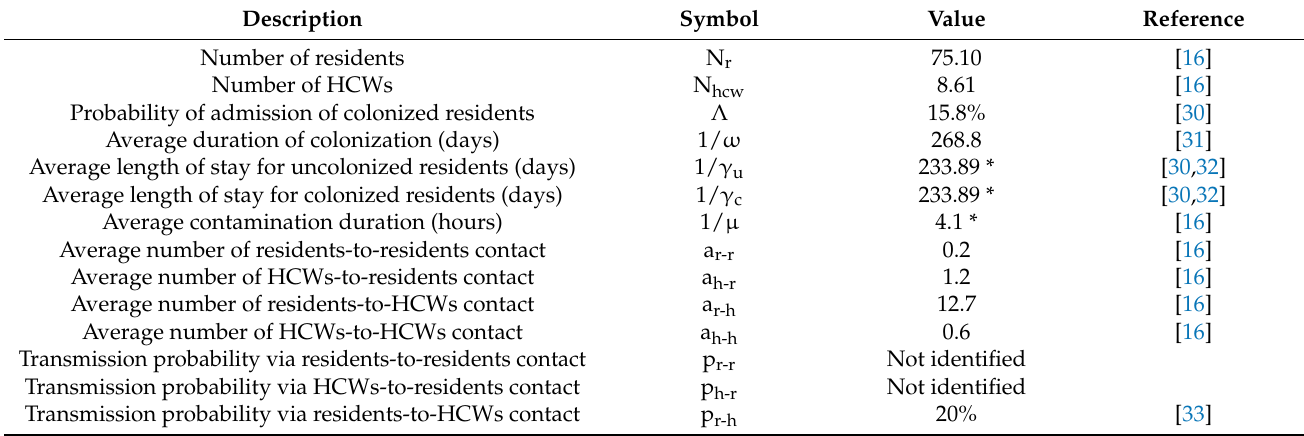
Table 5. List of the 14 parameter values used in the computational